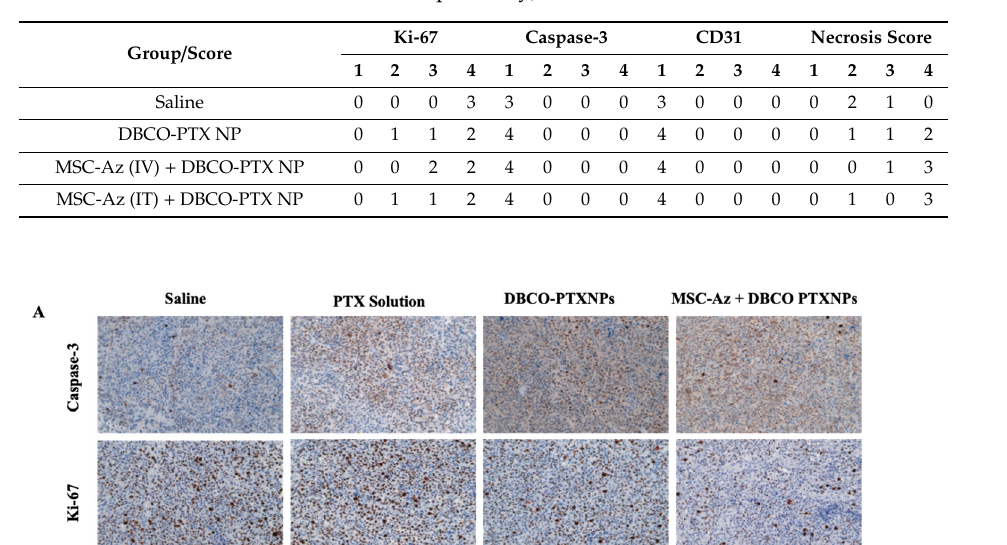
Table 2. Histological analysis of tumors collected at the end of the e ffi cacy study. Tumor tissues were evaluated semi-quantitatively and graded from 1–4 (1 ≤ 25% of the tumor cells positive, 2 ≥ 25 to 50% positive, 3 ≥ 50 to 75% and 4 ≥ 75 to100% cell positivity).